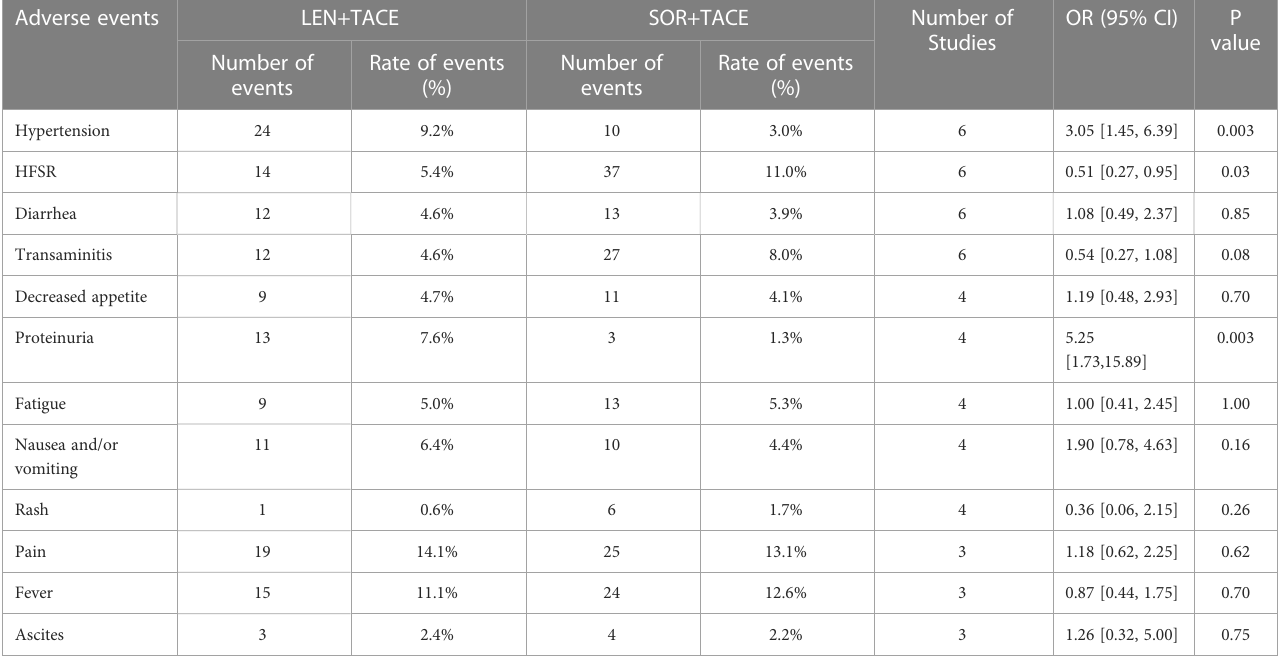
TABLE 4 Summary of treatment-related adverse